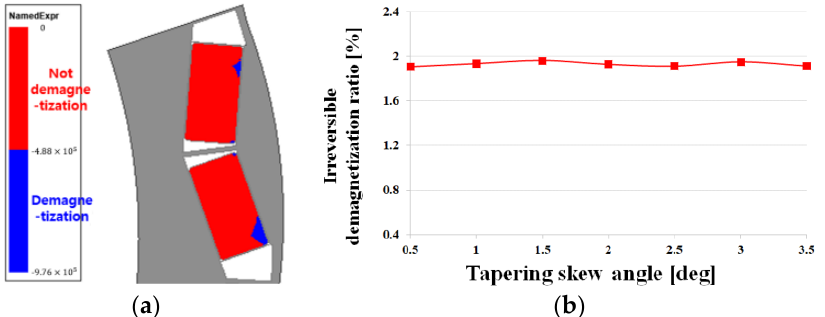
Figure 13. Irreversible demagnetization area and ratio depending on tapering skew angle: ( a ) irre- versible demagnetization area; ( b ) irreversible demagnetization ratio depending on tapering skew angle.